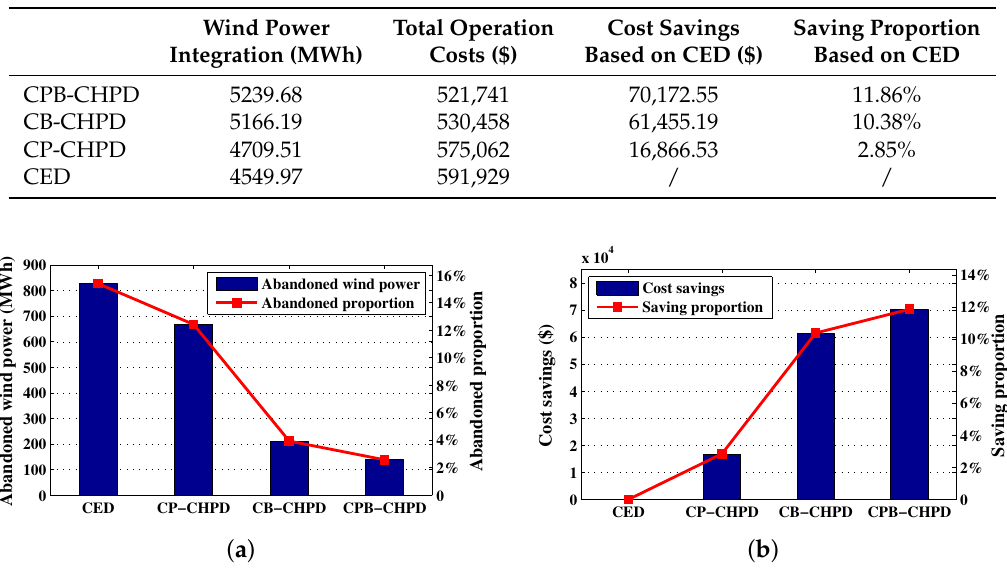
Table 4. Wind power integration and operation cost savings of the four dispatch models including the CPB-CHPD, CB-CHPD, CP-CHPD and CED models.